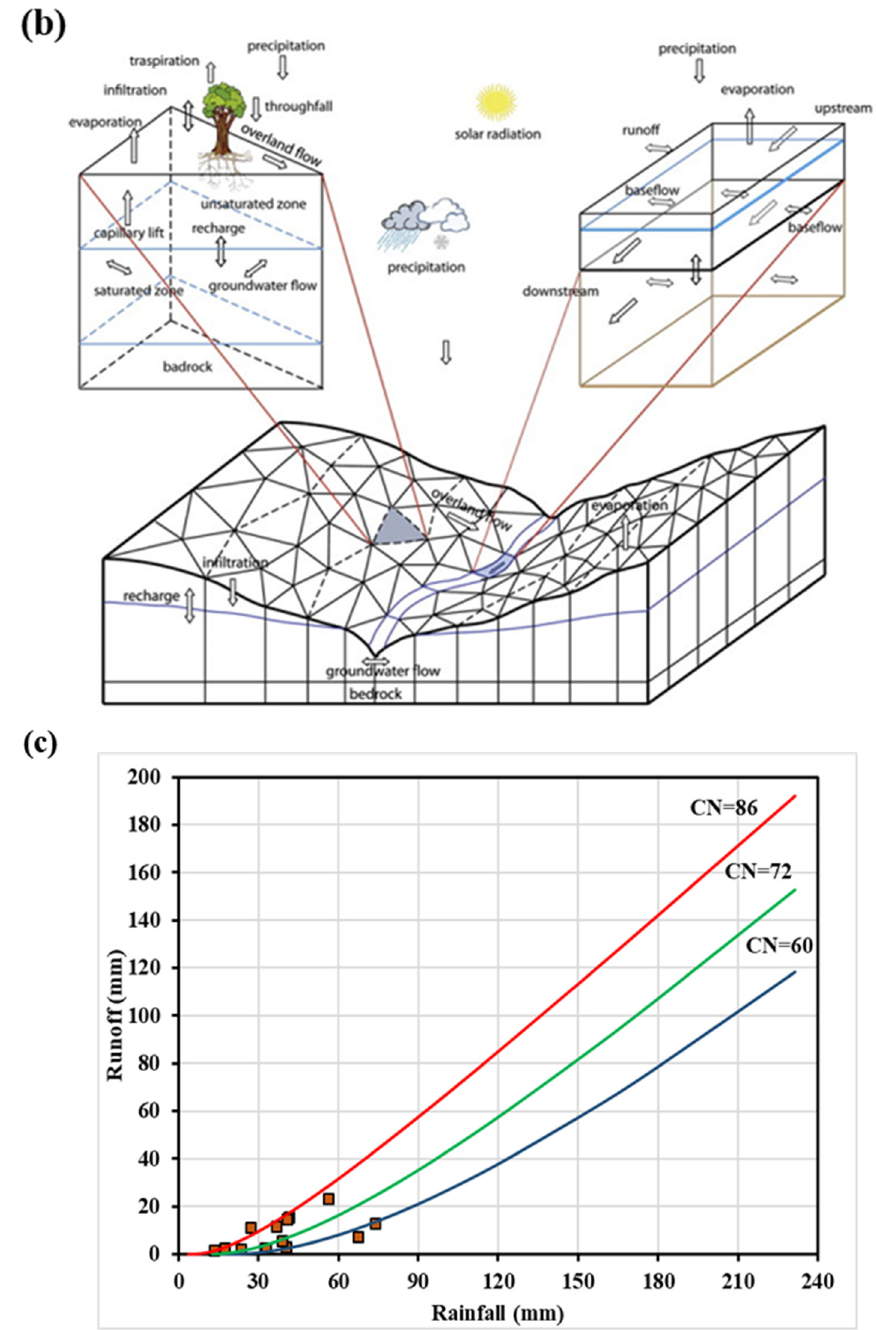
Figure 1. Schematic diagram of rainfall–runoff models: ( a ) conceptual model, ( b ) physical process- based model, ( c ) empirical model [34,37,38] .